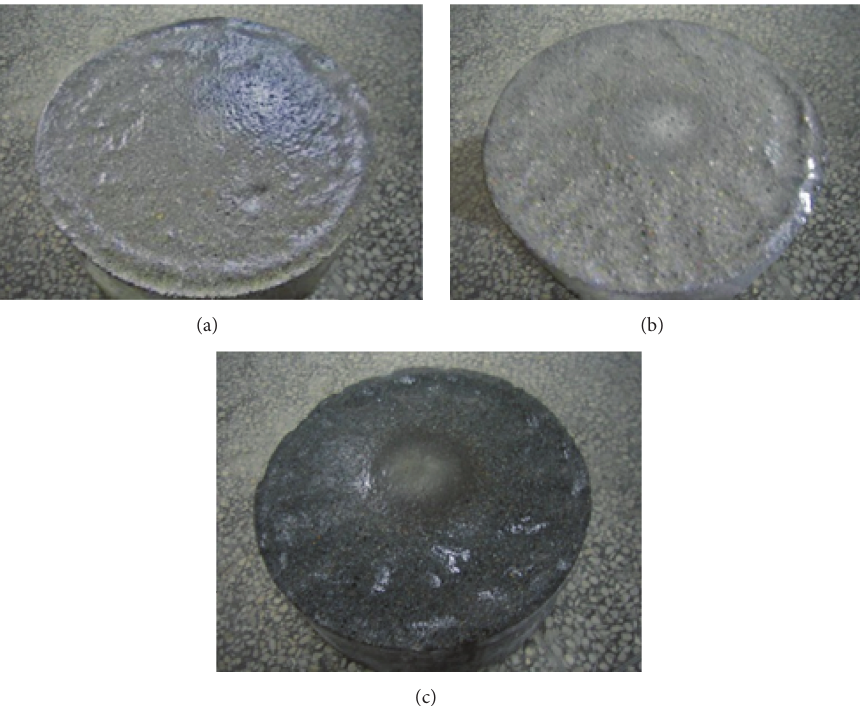
Figure 8: Surface morphology of FRM after 72 hours of abrasion: (a) PP FRM; (b) BFRM; (c) control